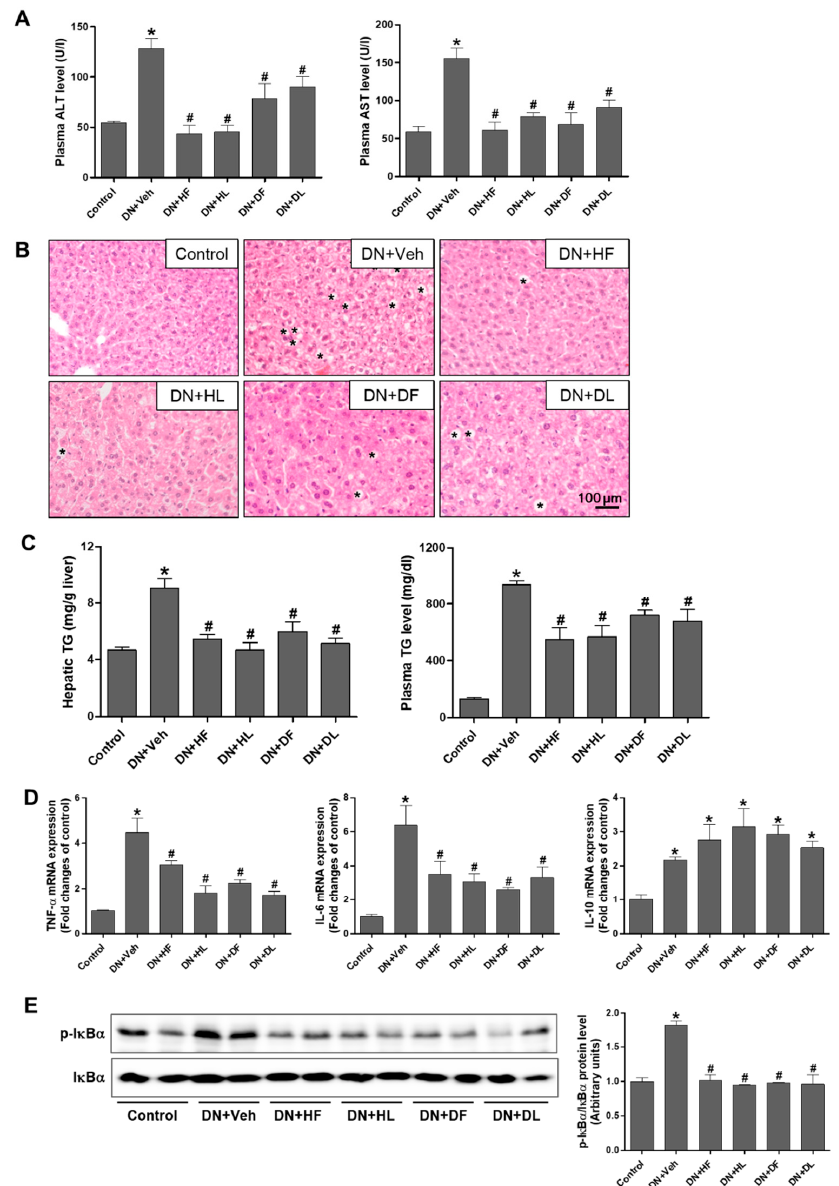
Figure 5. AM extract treatment reduced hepatic injury and lipid accumulation in DN mice. Blood and liver samples were collected from control, vehicle-treated or extract-treated DN mice and plasma ALT and AST ( A ) were measured. Liver tissues were processed for H&E staining and representative images are shown ( B ). Stars indicate lipid droplets. The levels of hepatic and plasma triglycerides were determined in hepatic lysates and plasma samples ( C ). Relative mRNA expression levels of TNF α , IL-6, and IL-10 were determined by real-time PCR analysis ( D ). Liver tissues were lysed for Western blot analysis and protein expression levels of p-I κ B( α ), I κ B( α ), and β -actin are shown. The quantitative analysis is included ( E ). The data are presented as the mean ± SEM. * p < 0.05 versus control, # p < 0.05 versus DN mice. Scale bar, 100 μ m.